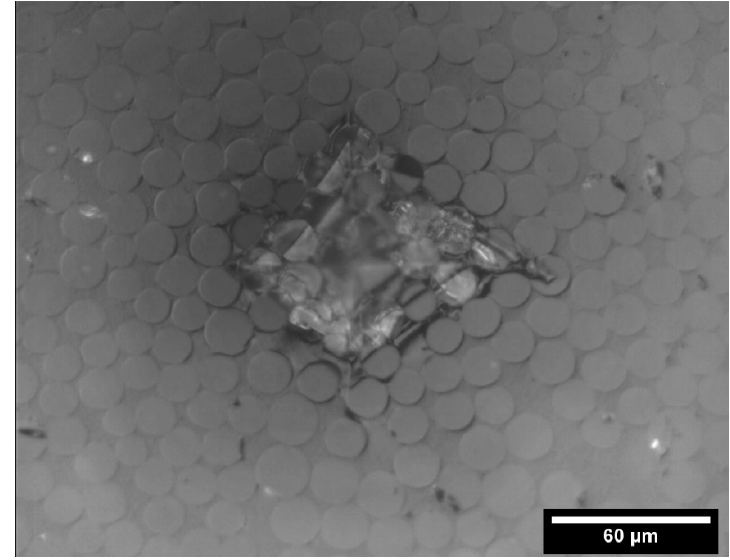
Figure 18. Image of an indenter imprint on the flat side surface of sample B2, 500×. Cracks and chipping of fiber fragments and resin damage as a result of the indenter operation are clearly visible.